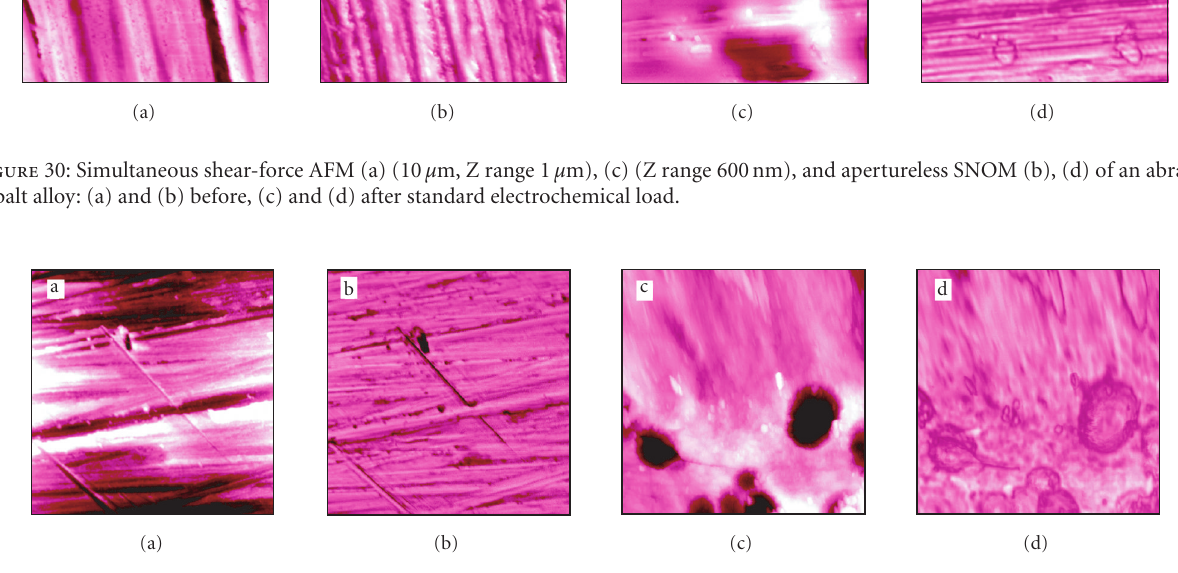
Figure 31: Simultaneous shear-force AFM (a) (10 μ m, Z range 300nm), (c) (Z range 1.6 μ m), and apertureless SNOM (b), (d) of an abraded nickel alloy: (a) and (b) before, (c) and (d) after electrochemical load, the optical images indicating nanoscopic